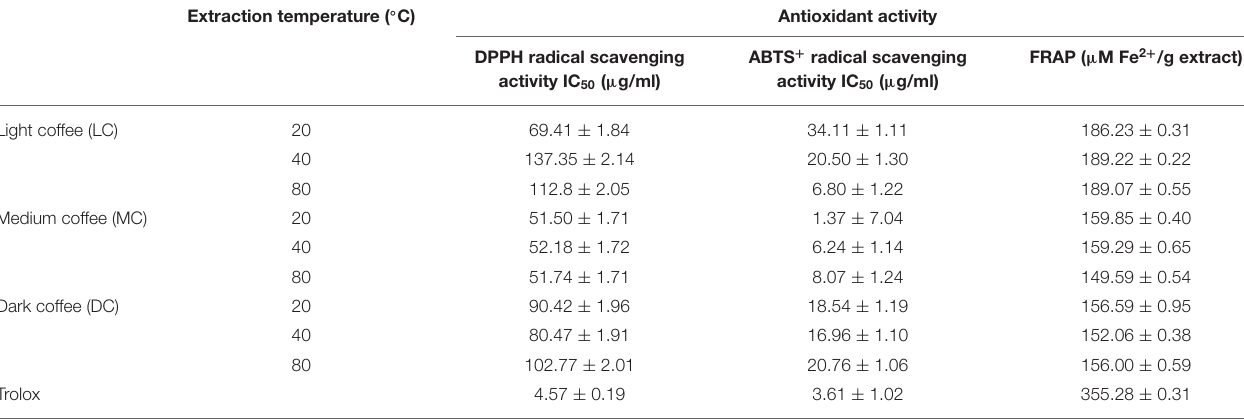
TABLE 5 | Antioxidant activity of coffee roasts extracts by 2,2 ′ -diphenyl-1-picrylhydrazyl (DPPH), 2,2 ′ -azino-bis(3-ethylbenzothiazoline-6-sulfonic acid) (ABTS), and ferric reducing antioxidant power (FRAP) assays. Extraction temperature ( ◦